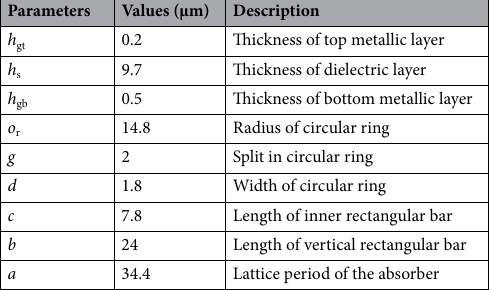
Table 2. Geometrical parameters of a metamaterial structure.